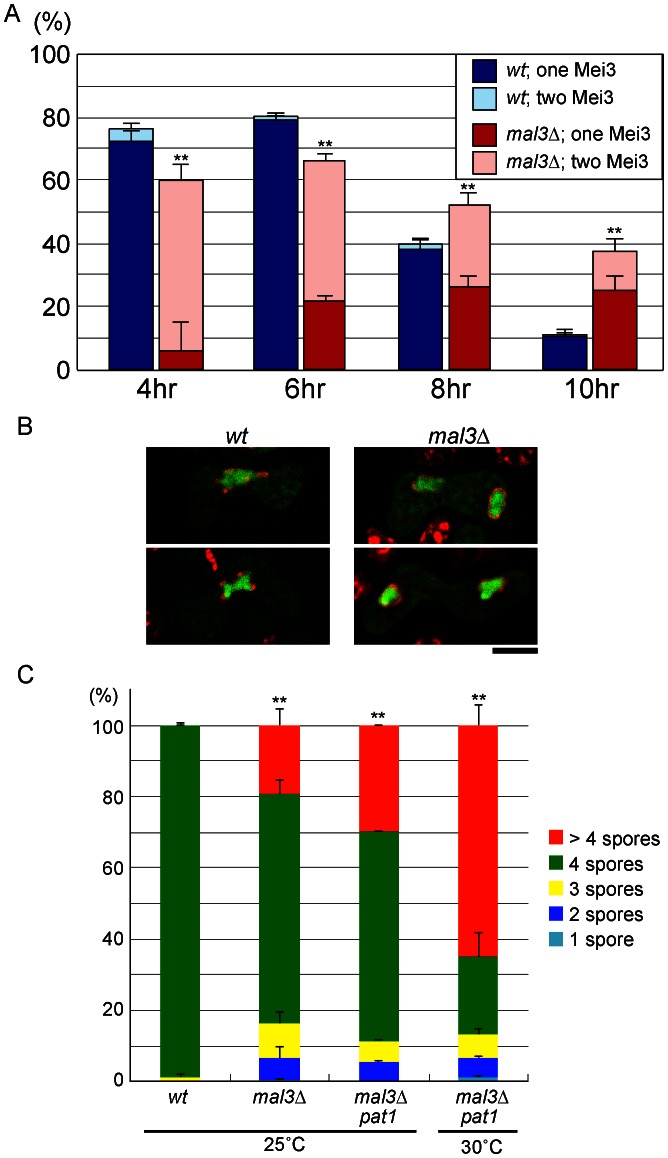
Twin haploid meiosis proceeds in a single mal3Δ zygote.(A) Percentage of mal3Δ zygotes containing one or two nuclei expressing Mei3-GFP. Wild-type (JT939) and mal3Δ (JT937) homothallic haploid cells carrying mei3-GFP and cut11-3mRFP were subjected to nitrogen starvation to induce conjugation and meiosis. More than 200 cells were examined microscopically following incubation for the indicated times to determine the number of zygotes expressing Mei3-GFP. Error bars indicate standard deviations from three independent experiments. Asterisks indicate significant difference from the wild-type strain (**p<0.01 (Chi-square test)). (B) Fluorescent micrographs of typical zygotes expressing Mei3-GFP in two nuclei. Wild-type (JT939) and mal3Δ (JT937) homothallic haploid cells were starved for nitrogen as in (A). Mei3-GFP is shown in green and the nuclear membrane marker Cut11-3mRFP is shown in red. Bar = 5 µm. (C) Percentage of asci containing 1, 2, 3, 4, or >4 spores generated by cells of the wild-type (JY450), mal3Δ (JW794), and mal3Δ pat1 (JT165) strains. Sporulation was induced in each strain by growth for 3 days on SSA medium at either 25°C or 30°C. More than 200 asci were examined for each strain. Error bars indicate standard deviations from three independent experiments. Asterisks indicate significant difference from the wild-type strain (**p<0.01 (Chi-square test)).